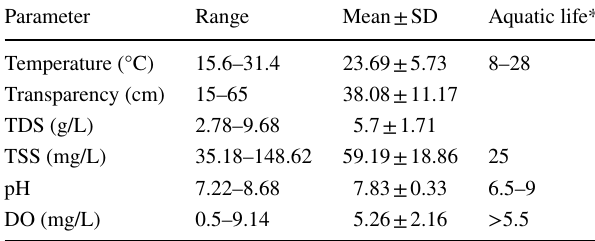
Table 2 General physicochemical parameters in Mariout Lake